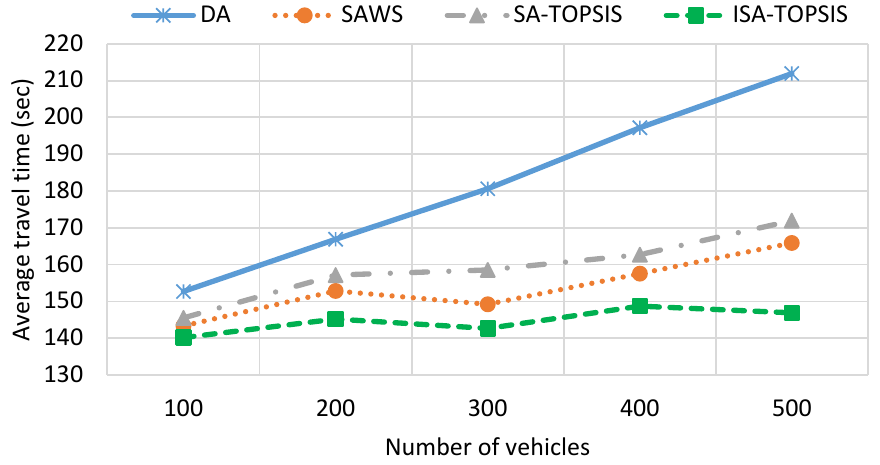
Figure 13. Average travel time in the Birmingham